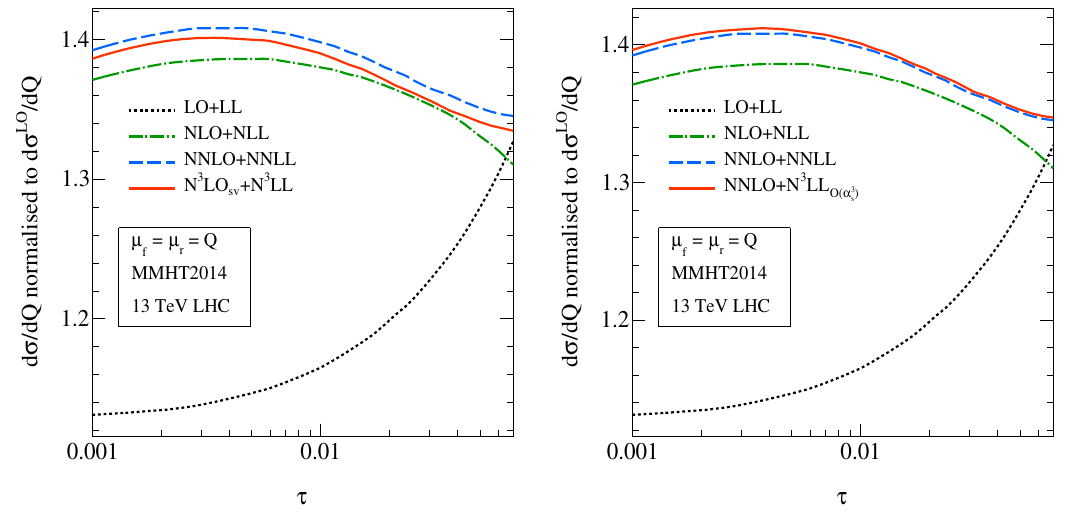
Figure 8 . Comparison between two di(cid:11)erent ways of matching with the (cid:12)xed order. In one case, the matching is done with threshold logarithms kept in the distribution ( z ) space (left) and in the other case the matching is done with threshold logarithms in the Mellin- N space (right).